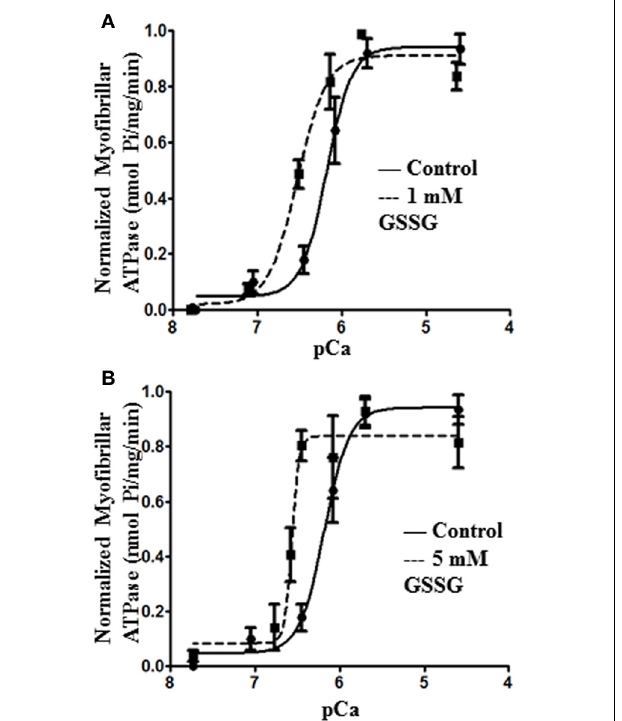
FIGURE 1 | Myofibril pCa-ATPase activity of control and GSSG treated samples. (A) In vitro ATPase activity of myofibrils prepared from wild type FVBN mouse heart treated with 1mM GSSG for 1h. pCa50 for control samples is 6.17 ± 0.09 (shown also in panel B ) and for 1mM GSSG treated samples is 6.50 ± 0.07 (B) In vitro ATPase activity of myofibrils prepared from wild type FVBN mouse heart treated with 5mM GSSG for 1h. pCa50 for control samples is 6.17 ± 0.09 and for 5mM GSSG treated samples is 6.60 ± 0.03. Data are expressed as mean ± standard error of mean, n = 4 from 1 preparation. In both panels (A) and (B) the change in pCa50 was significant ( P < 0 . 05). n H , minimum pCa, and maximum pCa values were not significantly